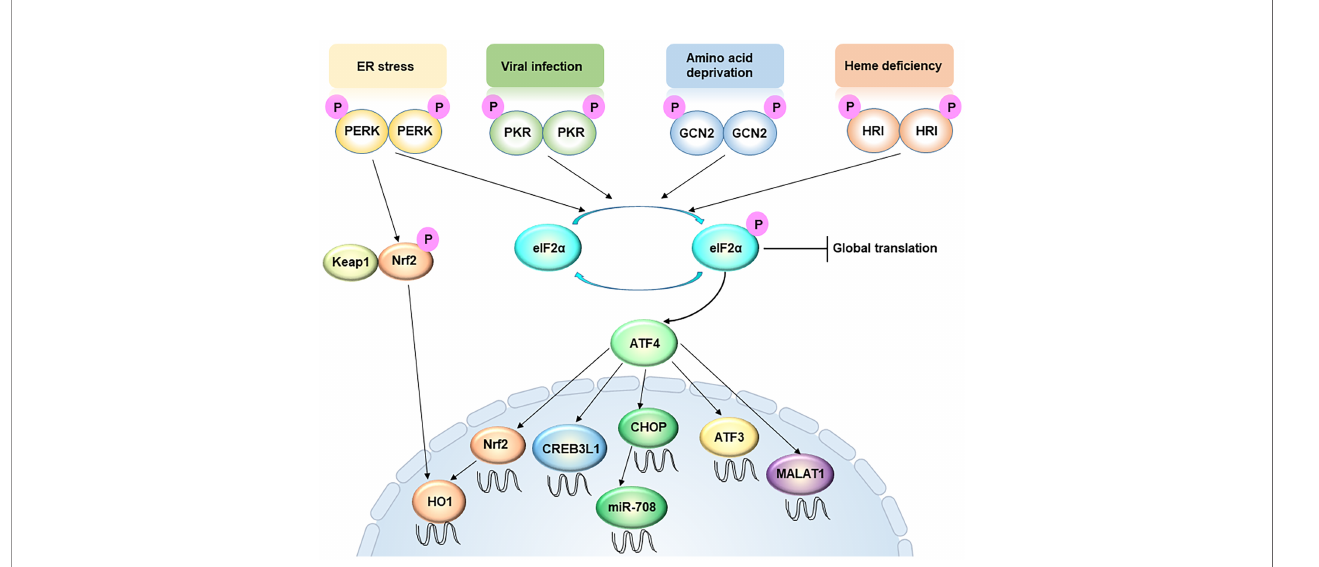
FIGURE 1 | Integrated stress response signaling, from a metastasis perspective. ER stress, viral infection, amino acid deprivation, and heme de fi ciency activate PERK, PKR, GCN2 and HRI, respectively. These four kinases converge on phosphorylation of eIF2 a , an initiation factor of protein synthesis, which leads to global translation attenuation but promotes the translation of certain speci fi c mRNAs, including ATF4. The PERK-ATF4 pathway is involved in oxidative resistance in two manners. On one hand, PERK directly phosphorylates Nrf2, causing the latter to disassociate with Keap1 and translocate into the nucleus. On the other hand, ATF4 directly drive Nrf2 transcription. Nuclear accumulation of Nrf2 triggers the transcription of redox homeostasis genes, including HO-1. ATF4 also enhances CREB3L1 transcription to promote cancer cell migration and invasion. However, ATF3, another target of ATF4, usually represses cell migration and invasion. In addition, LncRNA MALAT1 is a target of ATF4, which is critical for extravasation and subsequent outgrowth of cancer cells. MiR-708 can be up-regulated by CHOP, a downstream target of